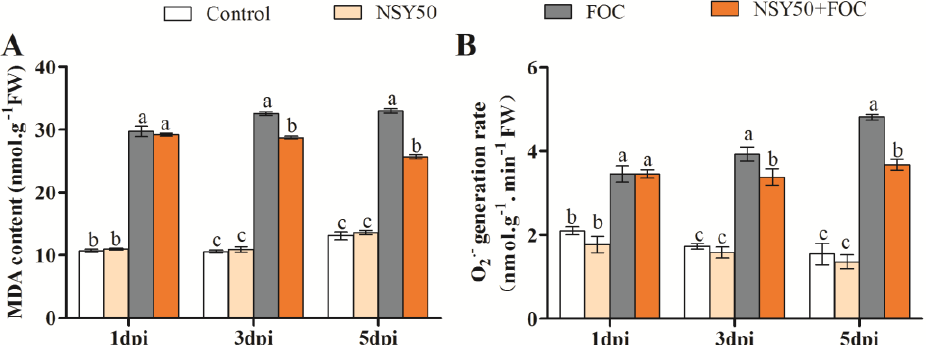
Figure 2. Effects of NSY50 on MDA content ( A ) and O 2 .- generation rate ( B ) of cucumber seedling roots at 1-, 3- and 5-days post-inoculation (dpi) with FOC in different treatments. Each value is means ± SE of three independent experiments. Values are the means ± SD, n = 3 (biological replicates), and different letters (a > b > c) indicate a significant difference at p < 0.05, as determined by Duncan’s multiple-range